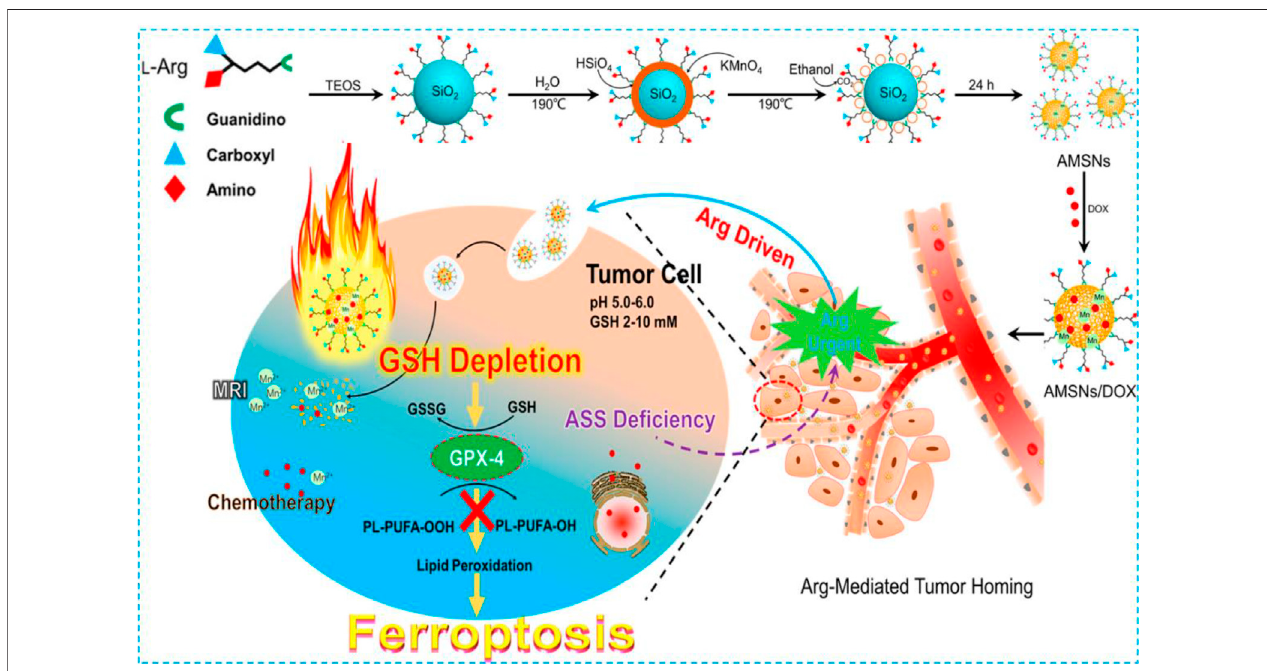
FIGURE 6 | Schematic illustration of the preparation and ferroptosis-induced cancer therapy of AMSNs. Reprinted with permission from Ref. (Wang et al., 2018). Copyright 2018 American Chemical Society.